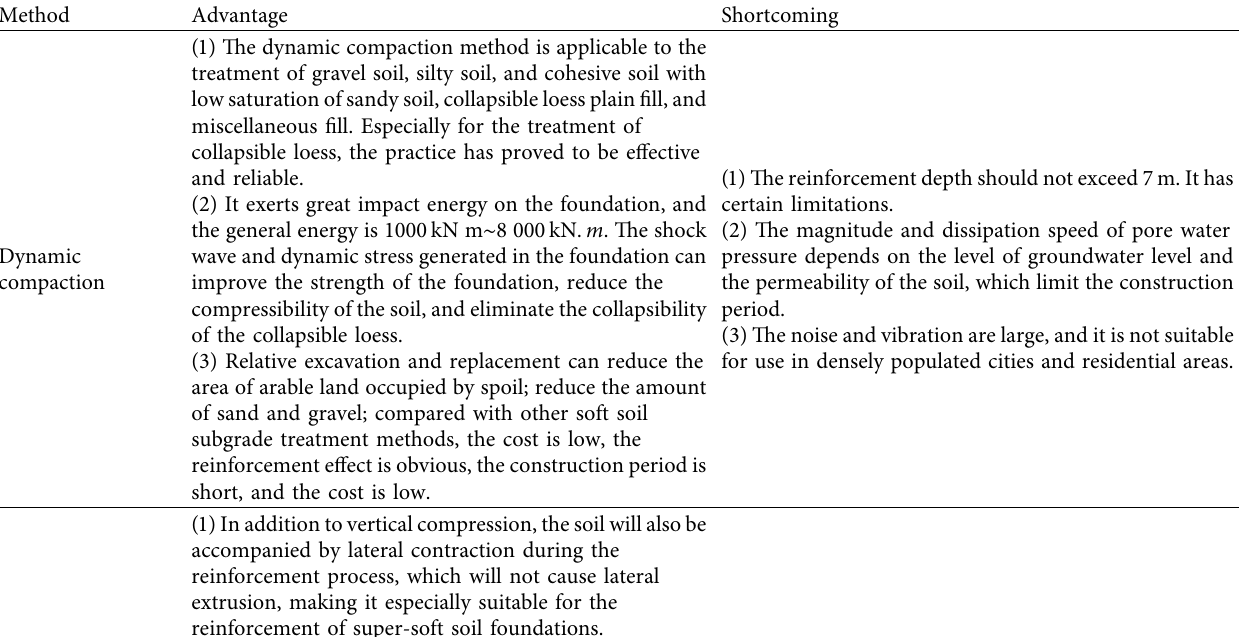
Table 2: Comparison of advantages and disadvantages of different treatment